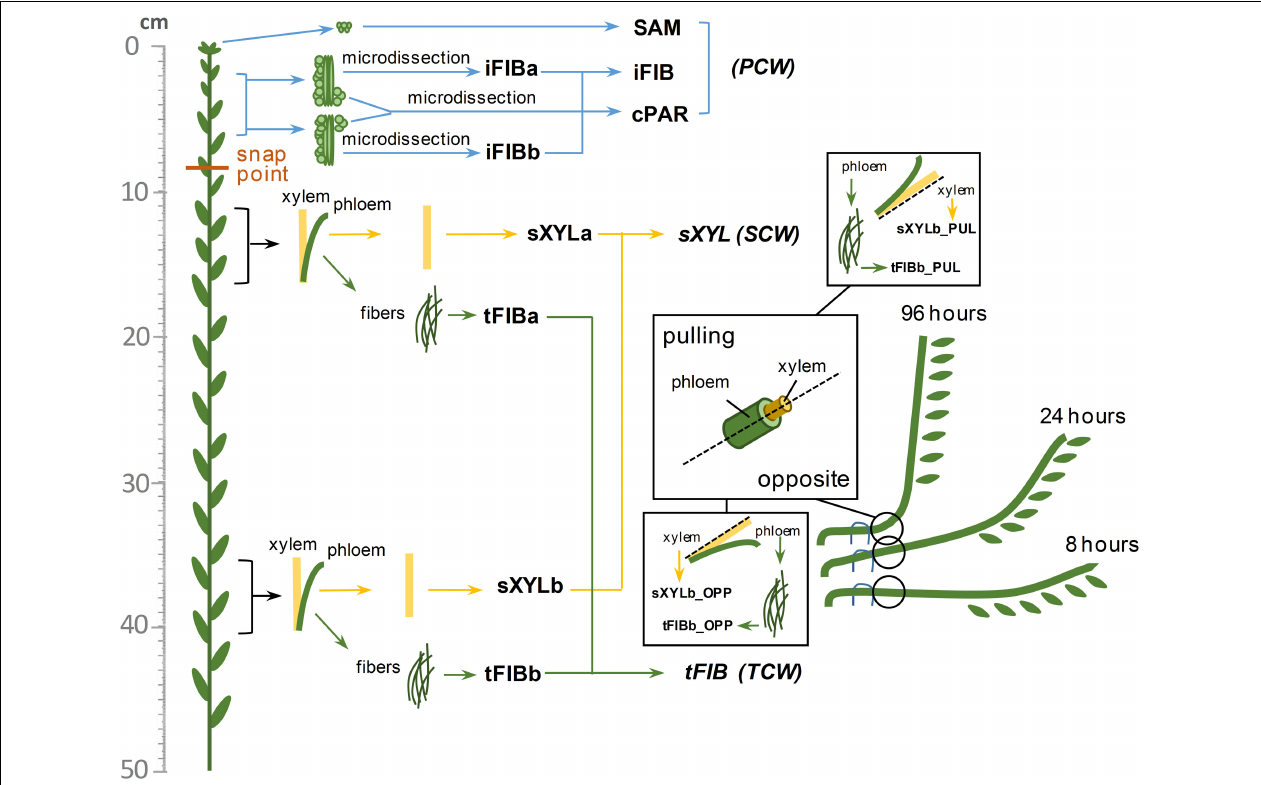
FIGURE 1 | Diagram of the samples collected from the flax stem. Abbreviations: SAM, shoot apical meristem; cPAR, cortical parenchyma; iFIB, phloem fibers at the stage of intrusive elongation; sXYL, stem xylem with secondary cell wall; tFIB, phloem fibers with tertiary cell walls; PCW, primary cell wall; SCW, secondary cell wall, TCW, tertiary cell